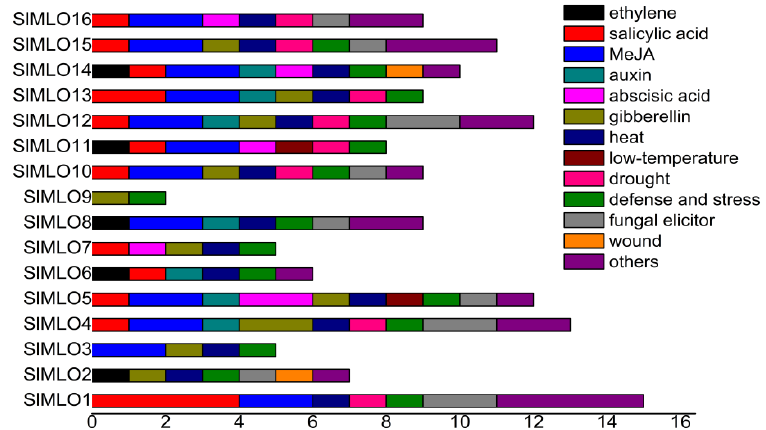
Figure 3. Cis-acting regulatory elements in the promoters of different SlMLO genes.